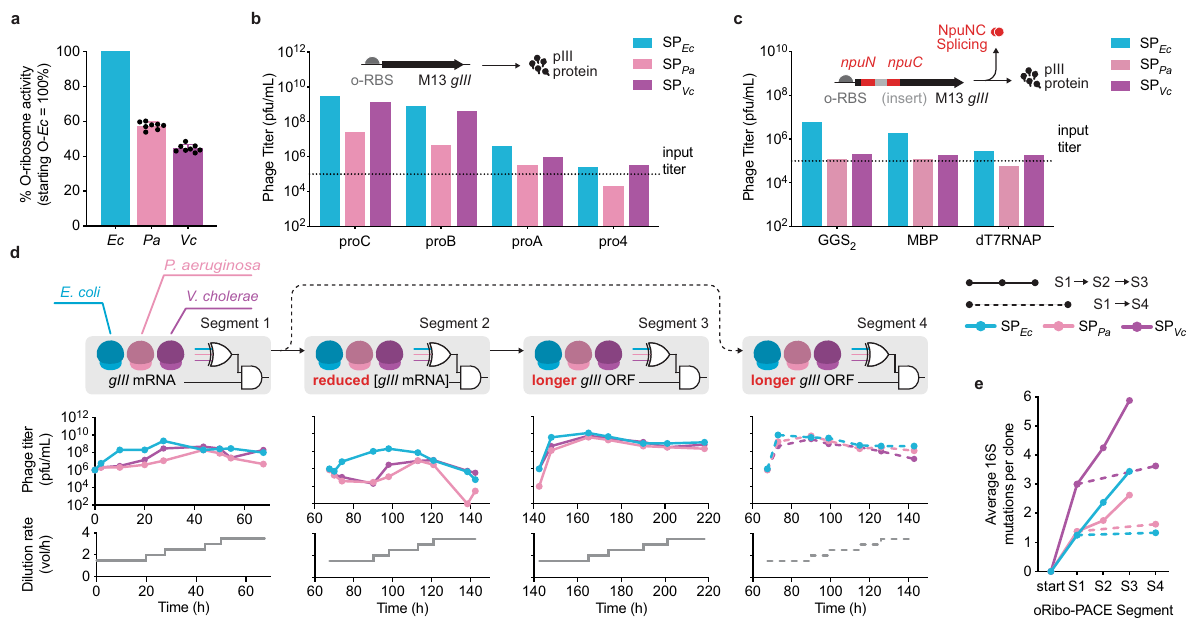
Fig. 3 Continuous directed evolution of orthogonal ribosomes. a Starting o-ribosome activity of E. coli ( Ec ), P. aeruginosa ( Pa ), and V. cholerae ( Vc ) o- rRNAs, quanti fi ed using sfGFP production. Data re fl ect the mean and standard deviation of 8 biological replicates ( n = 8). b Phage enrichment assays of SP Ec , SP Pa , and SP Vc in S3489 cells using APs encoding promoters of decreasing strength. c Phage enrichment assays of SP Ec , SP Pa , and SP Vc in S3489 cells encoding variable inserts within the intein-proB AP H3 architecture: GGS2 linker, MBP, and dT7RNAP. d Summary of PACE evolution trajectories. In the fi rst trajectory, oRibo-PACE was carried out in three segments (segments 1 → 2 → 3). In the second trajectory, a shorter oRibo-PACE campaign was carried out in two segments (segments 1 → 4). In all segments, high levels of mutagenesis (MP6) 18 were induced. Phage titers sampled during o-ribosome evolutions and lagoon fl owrates are shown on the bottom. e The average number of mutations per sequenced clone is highest in SP-borne o-rRNA derived from V. cholerae , followed by that of E. coli , while o-ribosome from P. aeruginosa on average had the lowest number of mutations at the end of each PACE segment. Colors blue ( E. coli ), pink ( P. aeruginosa ), and purple ( V. cholerae ) are consistent across plots. Source data are available in the Source Data